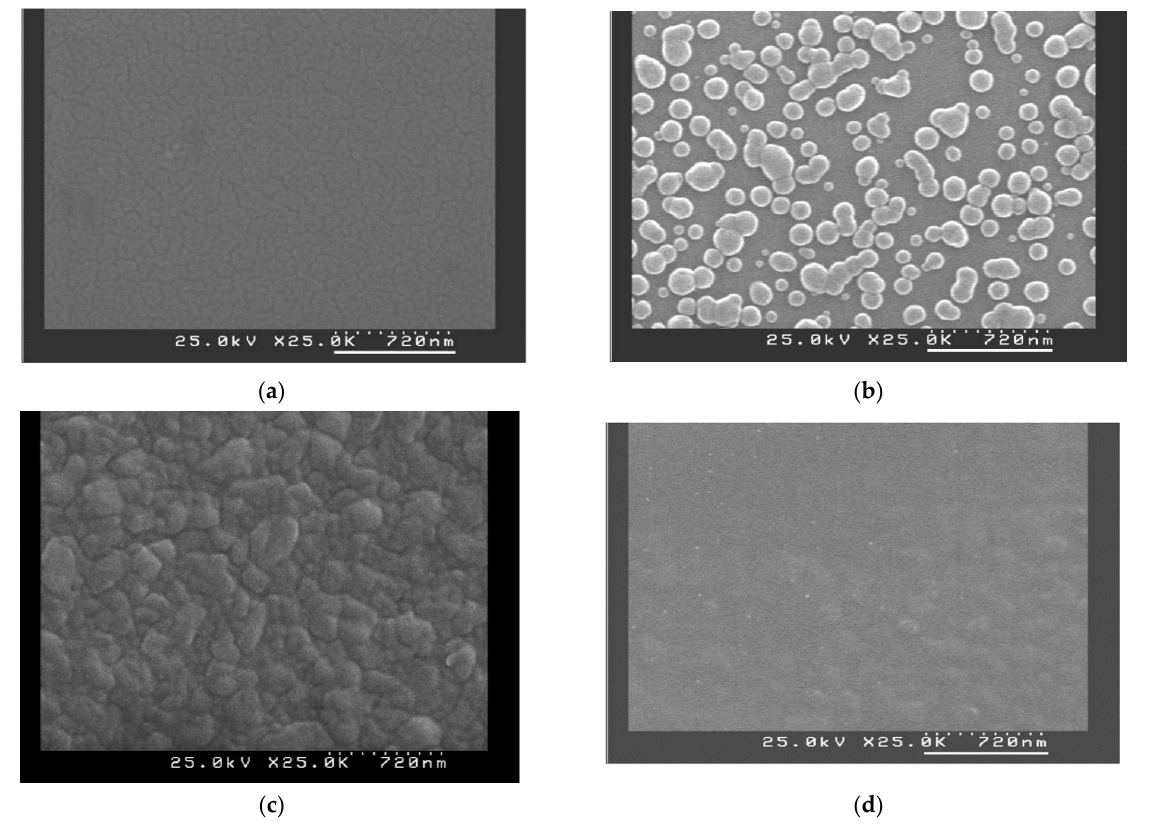
Figure 2. SEM images of poly-Si 0.8 Ge 0.2 film deposited ( a ) without annealing, and at different annealing temperatures of ( b ) 700 ◦ C, ( c ) 800 ◦ C, and ( d ) 900 ◦ C for 30